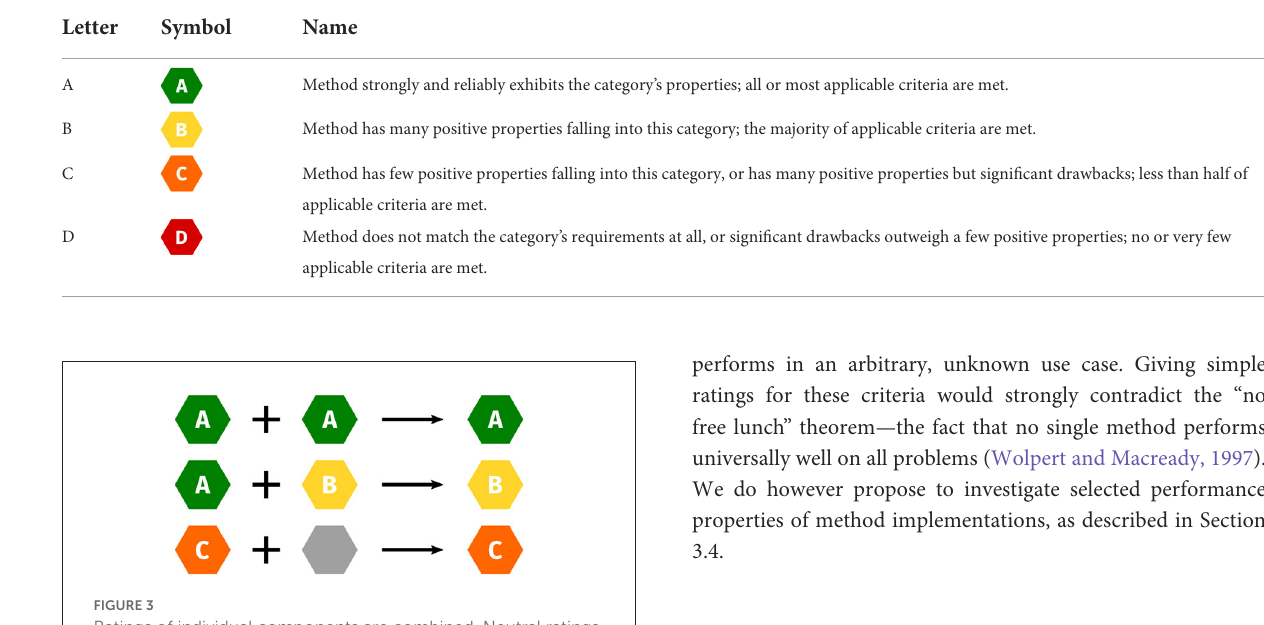
TABLE 2 Rating scale assigned to categories, depending on expert assessment, aided by proportion of fulfilled criteria.